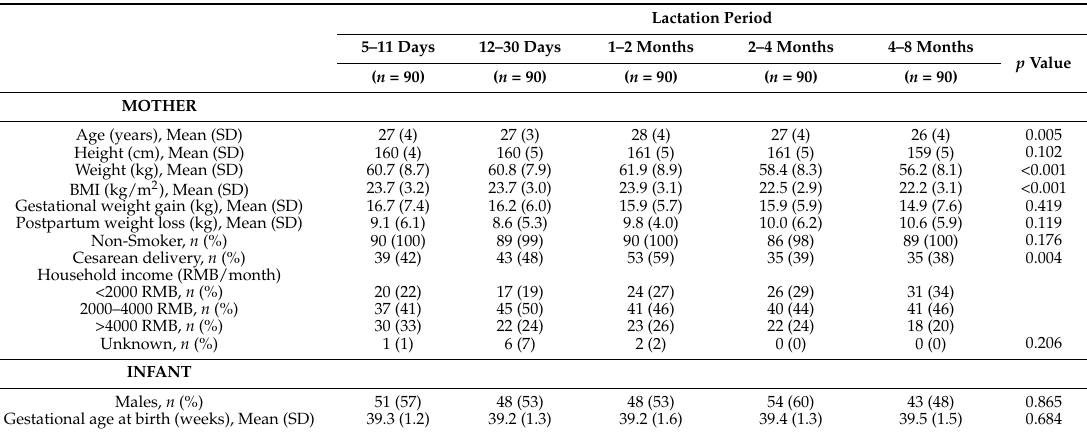
Table 1. Maternal and infant characteristics.